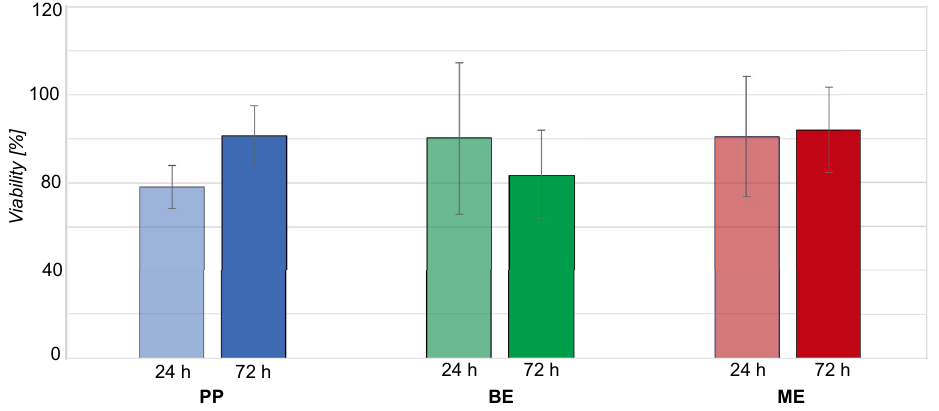
Figure 4. Viability of HGK after exposure to eluates of the tested polymers (PP, BE, ME) in the MTT assay. The first column of each group represents the cell index after incubation with the 24 h eluate and the second column with the 72 h eluate.